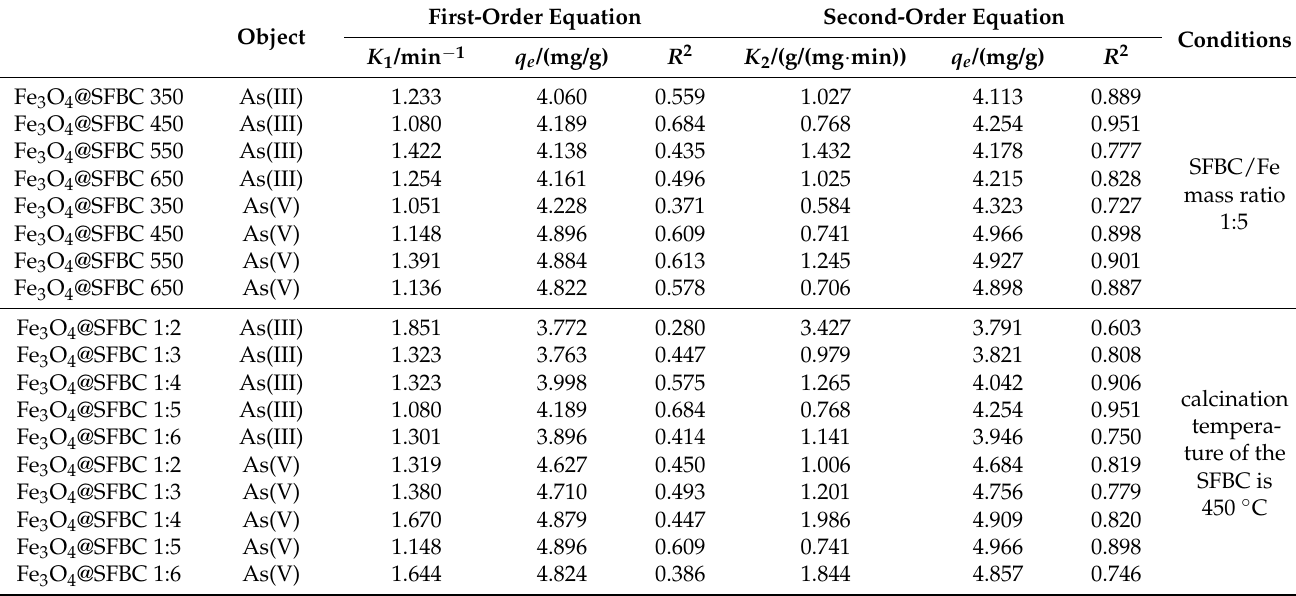
Figure 5. Adsorption kinetics of As(III) ( a ) and As(V) ( b ) on Fe 3 O 4 @SFBC (different SFBC/Fe mass ratios) (experimental conditions: pH = 6 and 4, dosage = 1 g/L, initial concentration = 5 mg/L, T = 25 °C). Table 1. Fitting parameters of adsorption